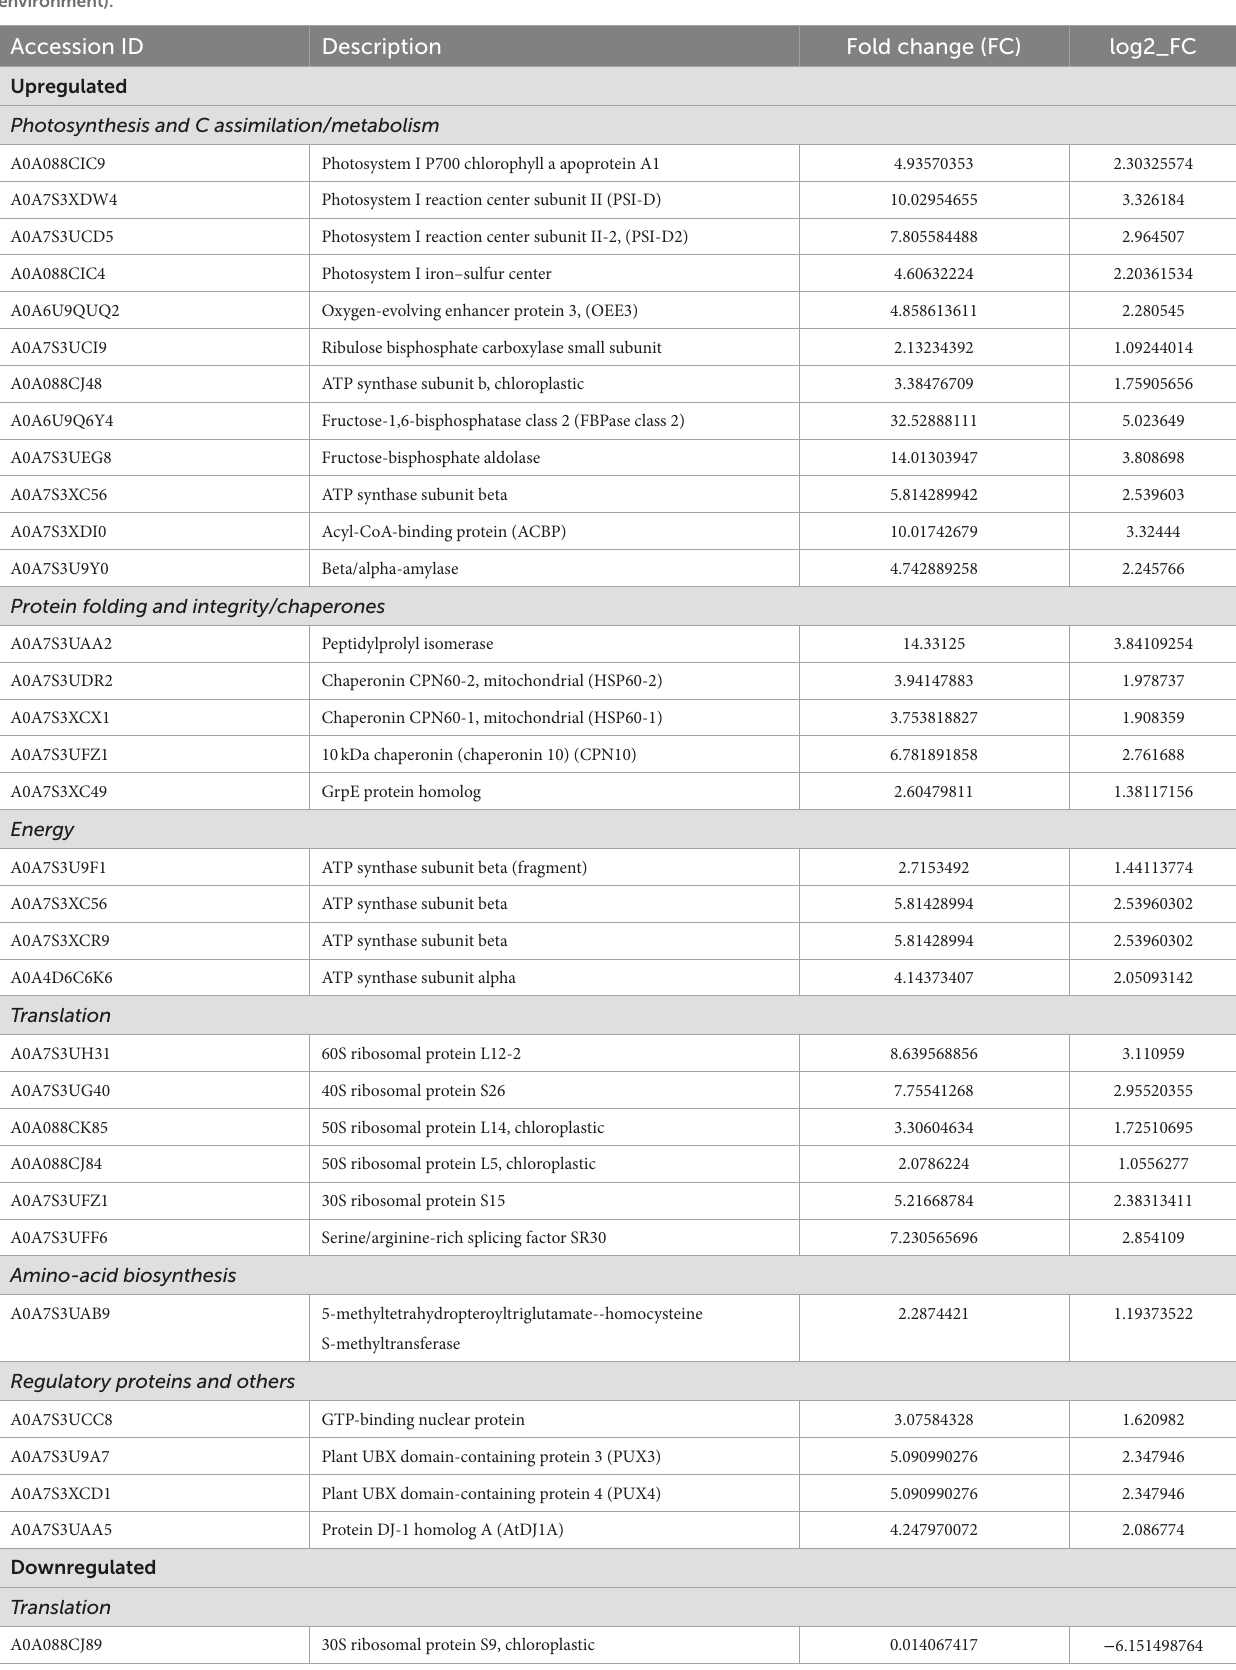
TABLE 1 Summary of protein changes in P. salinarum SLJS6 in response to high carbonates and NaCl concentrations (highly saline-alkaline